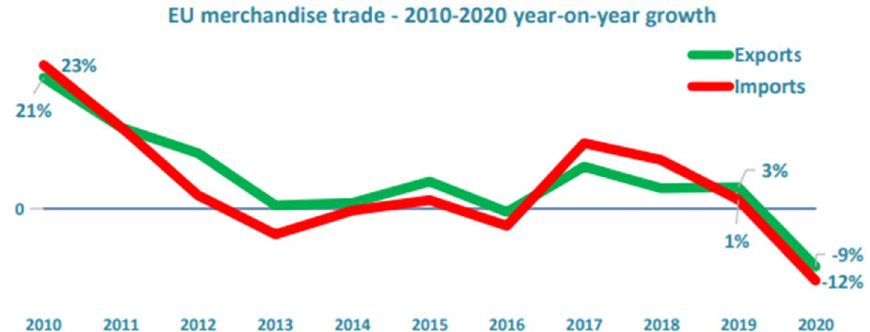
Fig. 2 EU merchandise trade—2010–2020 year-on-year growth. Source (DG Trade